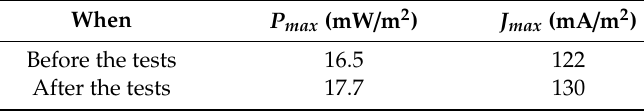
Table 2. Polarization and power curves